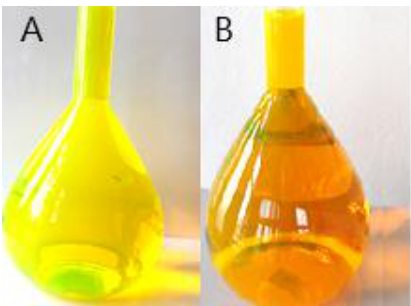
Figure 4. Change in color of uranine solution under the influence of light. Figure left — freshly prepared aqueous solution of uranine with a concentration of 100 mg/L ( A ), and the same solution exposed to light for 7 days ( B ) (photo: M. Gajec).